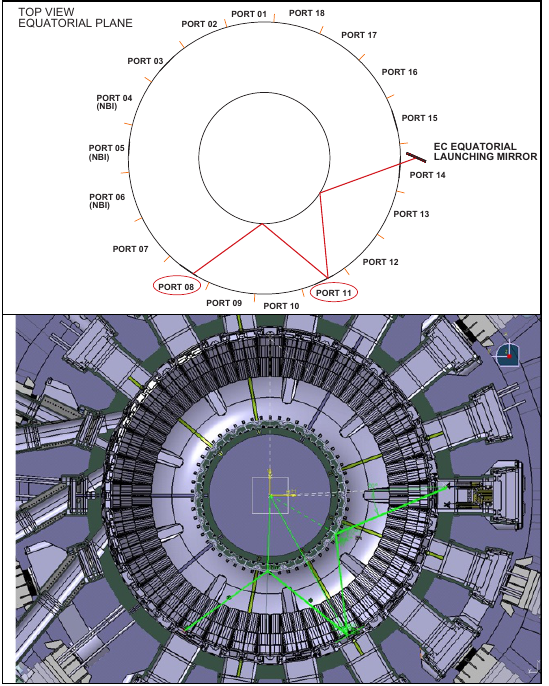
Fig. 10 . First reflection locations for beams injected from equatorial port 14 : above, geometrical representation of the beams; below, top view of tokamak equatorial plane section.